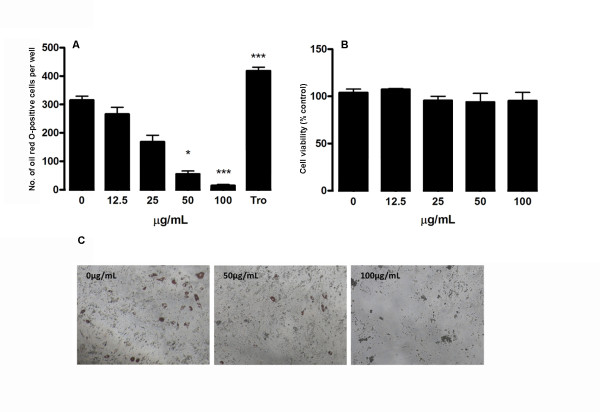
Inhibitory effect of FLL aqueous extract on rat MSCs under adipogenic induction on day 21. (A) The number of adipocytes was counted after Oil-red O staining. Troglitazone (Tro, 20 μM) acted as positive control. Data are the mean ± SD (n = 3) from three independent experiments. Significant difference: * P < 0.05; ** P < 0.01; *** P < 0.001 for difference from respective baseline cultures without treatment. (B) Effect of FLL aqueous extract on the cell viability of P2 adipogenic differentiated rat MSCs. MSCs were treated with different concentrations of FLL extract for 21 days. The cell viability was estimated by MTT assay and the results are expressed as mean ± SD of three independent experiments in triplicate. (C) Adipocyte deposition at different treatment concentrations (0, 50 and 100 μg/mL) was visualized by Oil Red O staining on day 21.